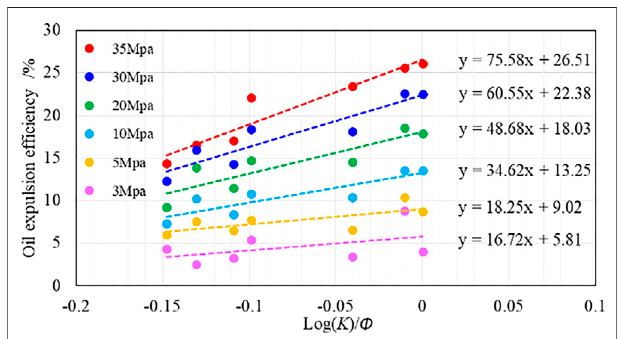
FIGURE 11 | Relationship between parameters A and B (A) , and relationship between parameter A and differential pressure (B) .